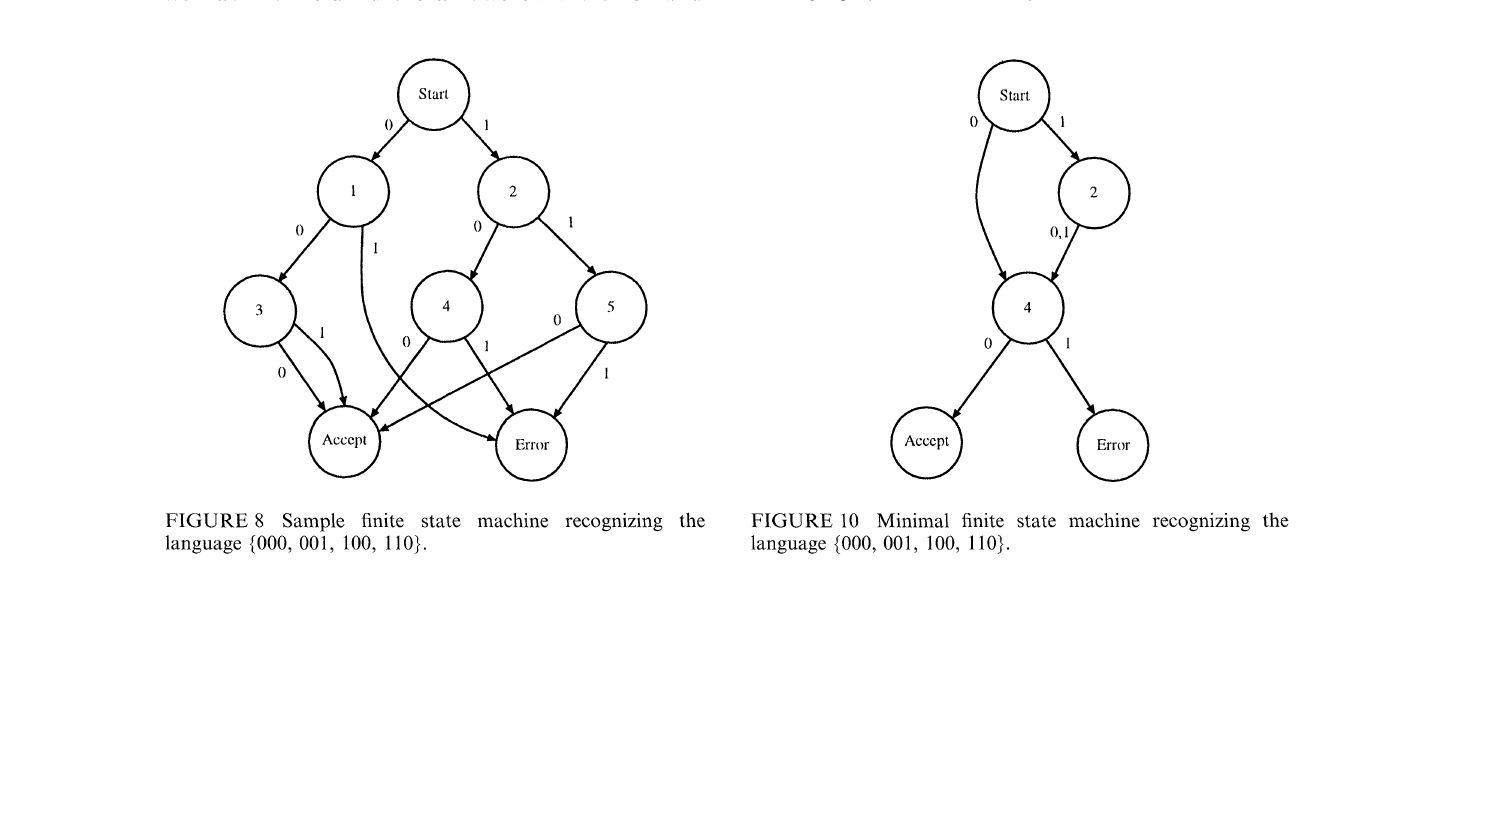
FIGURE 8 Sample finite state machine recognizing the language {000, 001, 100, 110}.